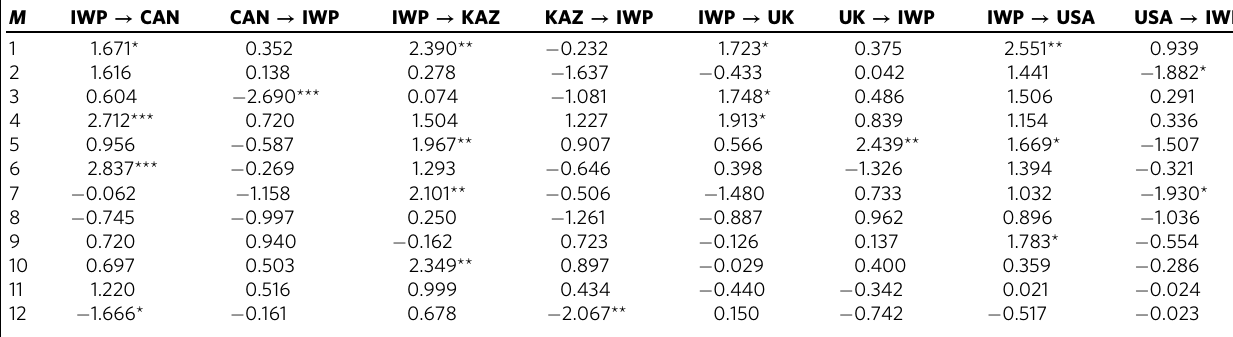
Table 5 Test statistics for